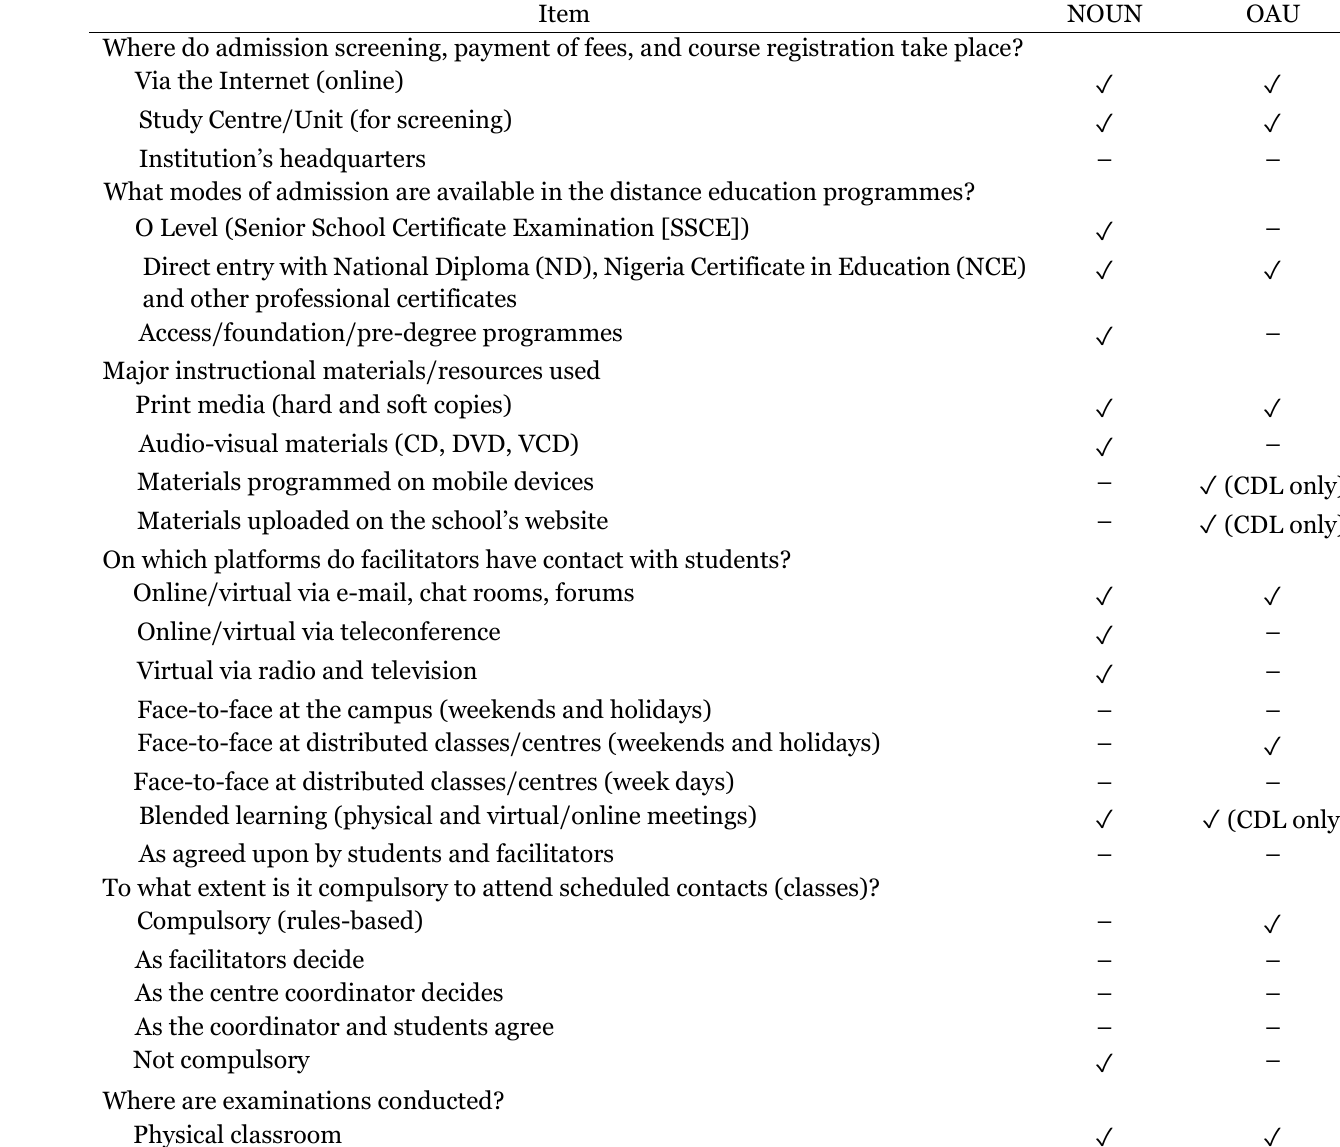
Operational Structures of Distance Education at NOUN (Single Mode) and OAU (Dual